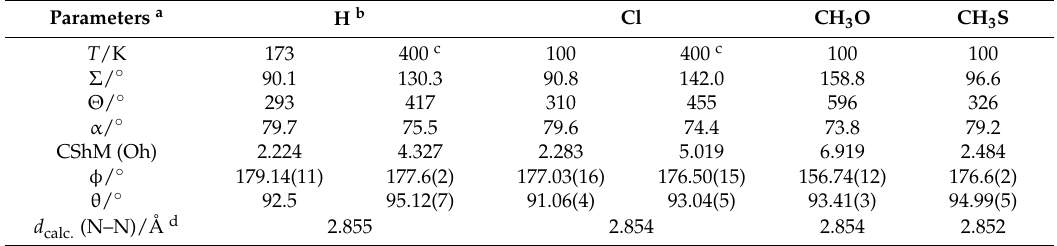
Table 4. Distortion parameters for [Fe(X-pybox) 2 ](ClO 4 ) 2 (X = H, Cl, CH 3 O, CH 3